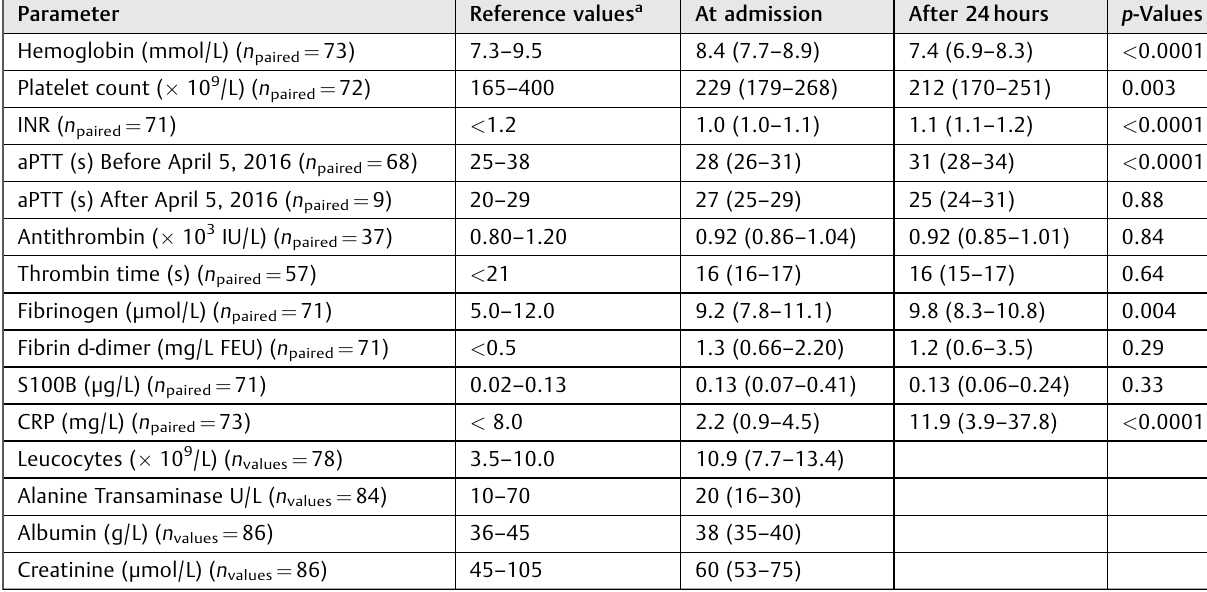
Table 1 Biochemical values at time of admission to hospital and 24 hours after symptom onset in 87 patients with intracerebral or subarachnoid